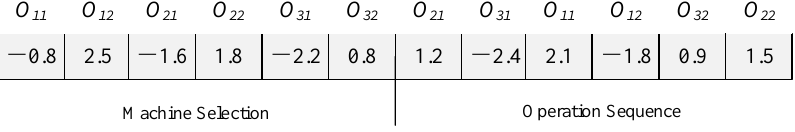
Figure 3. Denotation of Individual Position Vector (IPV).